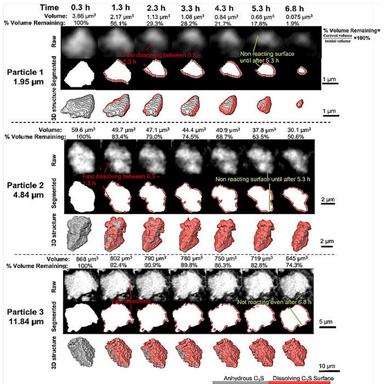
Microstructural evolution of three C3S particles at different times of hydration. 2D raw and segmented images of one cross-section and the 3D structure are shown for more insights. The red layers in the figure were added to show surfaces where anhydrous solids dissolved compared to the first-time step. (For interpretation of the references to colour in this figure legend, the reader is referred to the web version of this article.) Image reproduced from.